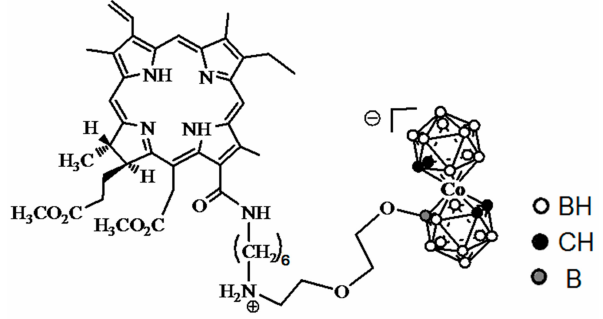
Figure 1. Structure of the studied chlorin e 6 -Cobalt bis(dicarbollide) conjugate (CCDC).